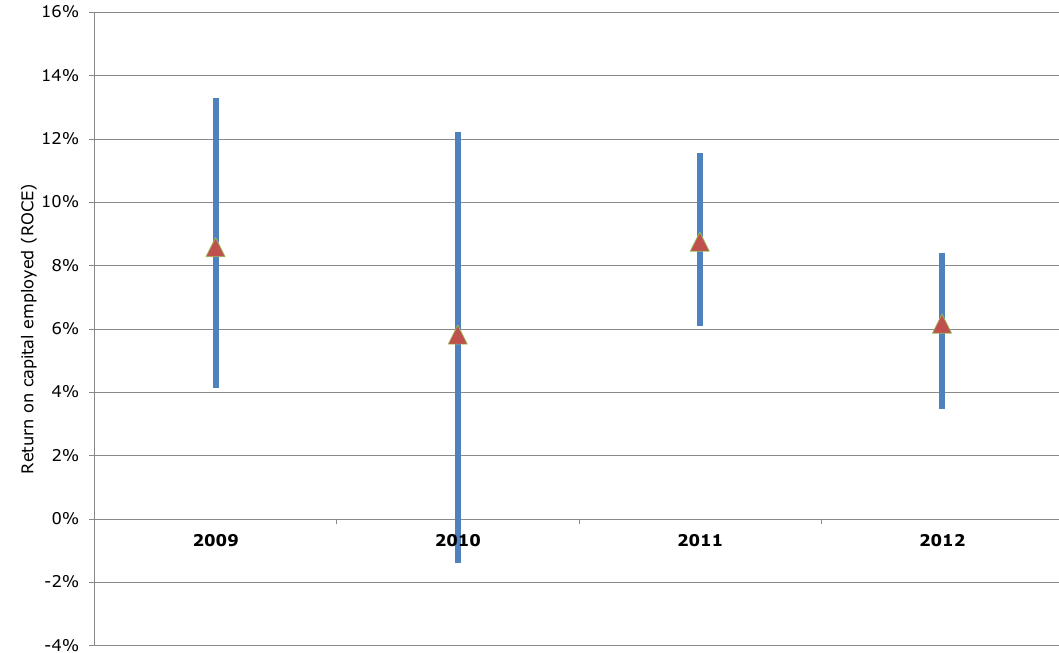
Figure 54: Generation ROCE (adjusted EBIT) average across the six largest